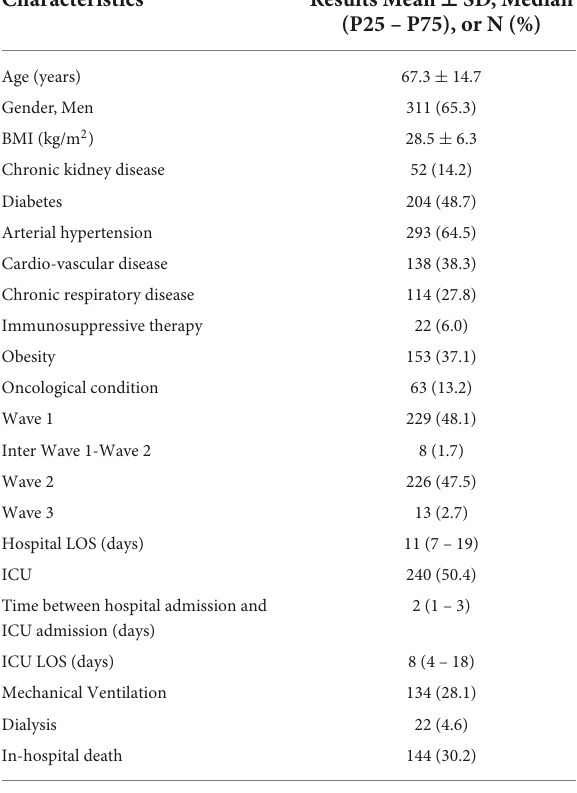
TABLE 1 Patients’